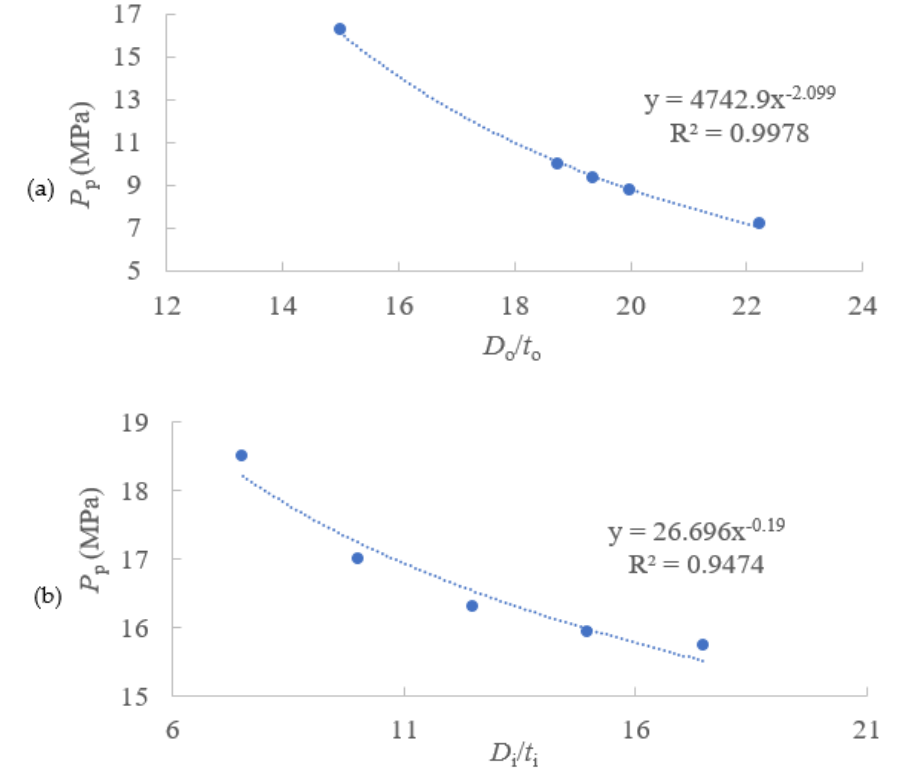
Figure 12. Relationship between buckle propagation pressure and D / t ratios: ( a ) outer pipe and ( b ) inner pipe ( D o = 60 mm, D i = 25 mm).